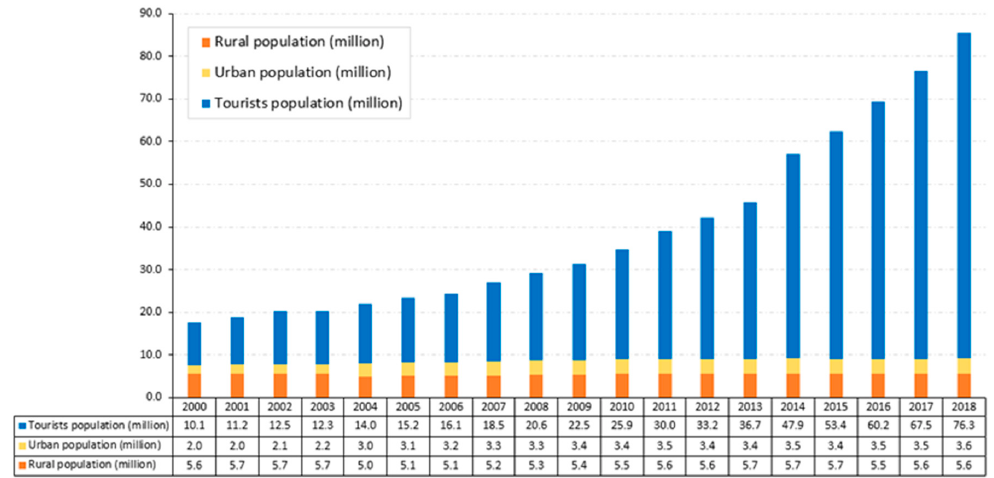
Figure 4. Population figures for Hainan Island from 2000 to 2018 (The data source is the Annual Statistics Yearbook from National Bureau of Statistics of China (2000 to 2018) listed in Table 1).